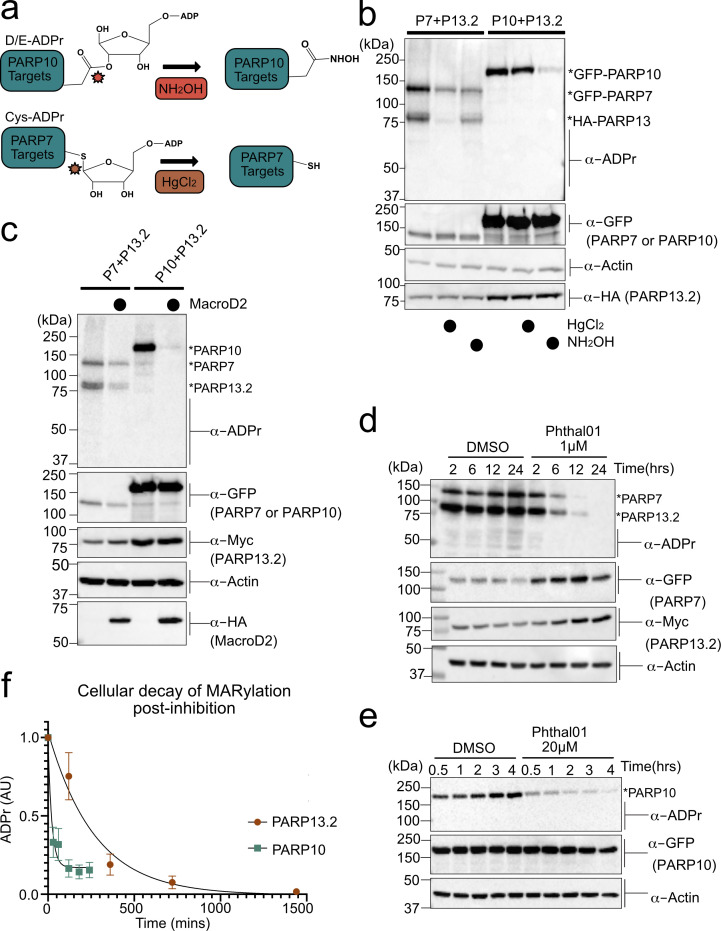
PARP-13 is MARylated by PARP-7 predominately on Cys residues and Cys MARylation is more stable than Asp/Glu MARylation in cells.(a) Schematic of chemical stability studies for analyzing the amino acid-ADPr linkage. Neutral hydroxylamine (NH2OH) removes ADPr from acid residues to generate a hydroxamic acid, while mercuric chloride (HgCl2) removes ADPr from Cys residues. (b) PARP-7 MARylates predominately on Cys residues whereas PARP-10 MARylates predominately on Glu/Asp residues. GFP-PARP-7/HA-PARP-13.2 or GFP-PARP-10 alone were expressed in HEK 293 T cells. Lysates were prepared and treated with either water control, HgCl2 (2 mM), or NH2OH (0.4 M). Following treatment, proteins were precipitated with ice cold methanol, and resolved by SDS-PAGE and were detected by Western blot using antibodies against ADPr, GFP, HA, and actin. Representative figure of data collected over three biological replicates. (c) The Glu/Asp selective ADPr hydrolase MacroD2 efficiently removes ADPr from PARP-10, but only partially removes ADPr from PARP-7 and PARP-13. GFP-PARP-7/MycX2-PARP-13.2 or GFP-PARP-10 was co-expressed with either HA-MacroD2 or mCherry (negative control) in HEK 293 T cells. Proteins were resolved by SDS-PAGE and were detected by Western blot using antibodies against ADPr, GFP, Myc, and actin. Representative figure of data collected over three biological replicates. (d) Time course of Cys MARylation in cells. GFP-PARP-7 and MycX2-PARP-13.2 were co-expressed in HEK 293 T cells. Cells were treated with either DMSO or Phthal01 (1 µM) to stop PARP-7 MARylation. Cells were harvested at indicated time points and proteins were resolved by SDS-PAGE and were detected by Western blot using antibodies against ADPr, GFP, Myc, and actin. Representative figure of data collected over three biological replicates. (e) Time course of Glu/Asp MARylation in cells. GFP-PARP-10 was expressed in HEK 293 T cells. Cells were treated with either DMSO or Phthal01 (20 µM) to stop PARP-10 MARylation. Cells were harvested at indicated time points and proteins were resolved by SDS-PAGE and were detected by Western blot using antibodies against ADPr, GFP, and actin. Representative figure of data collected over five biological replicates. (f) Quantification of replicate data from (d) and (e). ADPr signal is normalized to either GFP-PARP-10 or MycX2-PARP-13.2. Data are ± SEM.